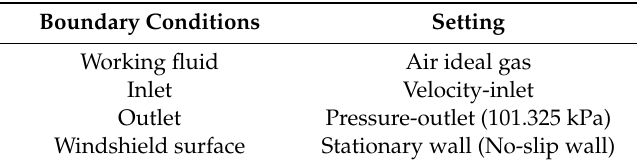
Table 1. Boundary